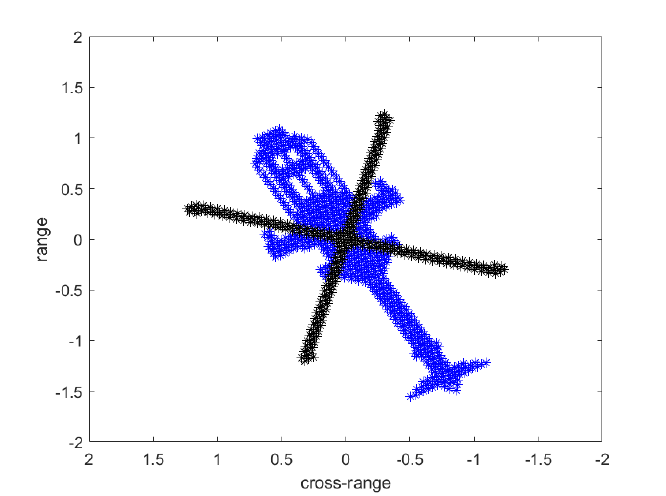
Figure 3. ISAR geometric